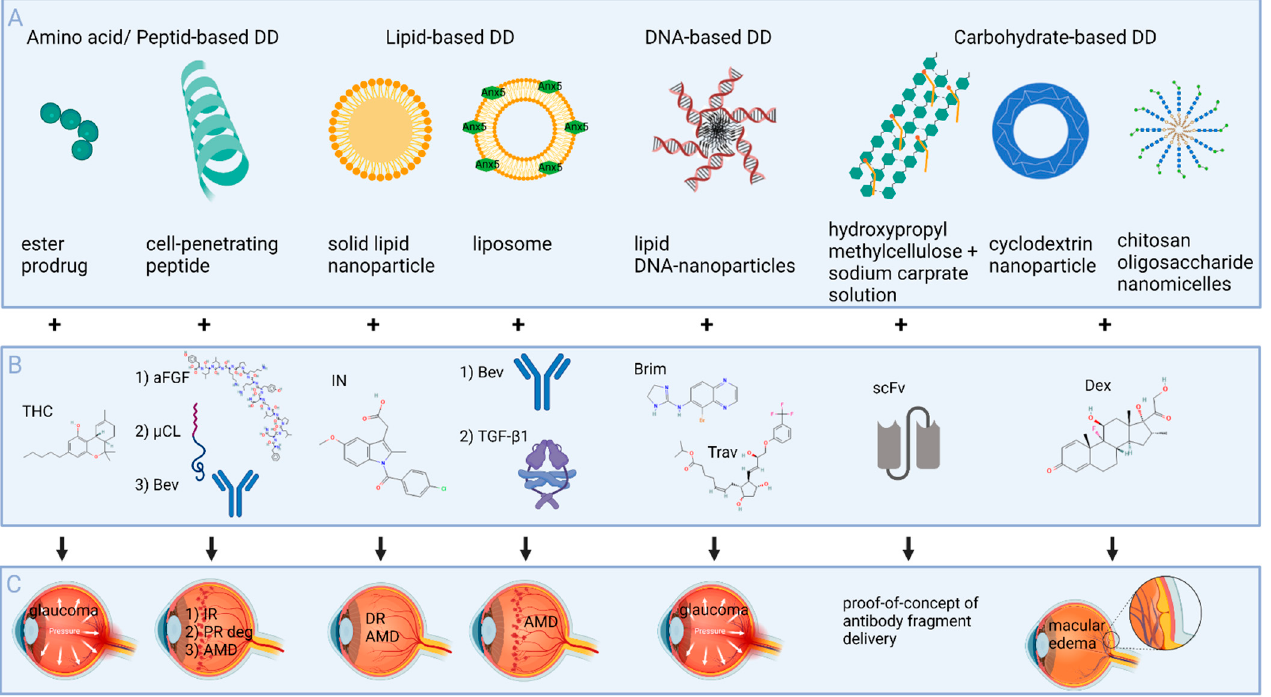
Figure 2. Schematic presentation of drug delivery (DD) systems and formulation approaches to improve topical delivery to the back of the eye. ( A ) Drug delivery systems presented in this review. ( B ) Drugs that were transported by those delivery systems. ( C ) Diseases that are addressed with the DD system and drug. The molecular structures were obtained from https://pub-